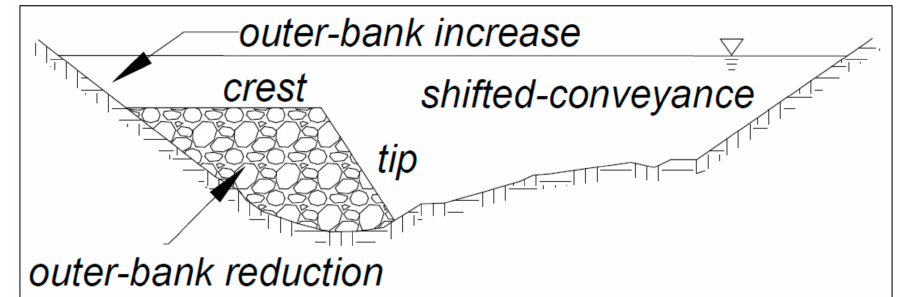
Figure 12. Cross-sectional bendway weir hydraulic